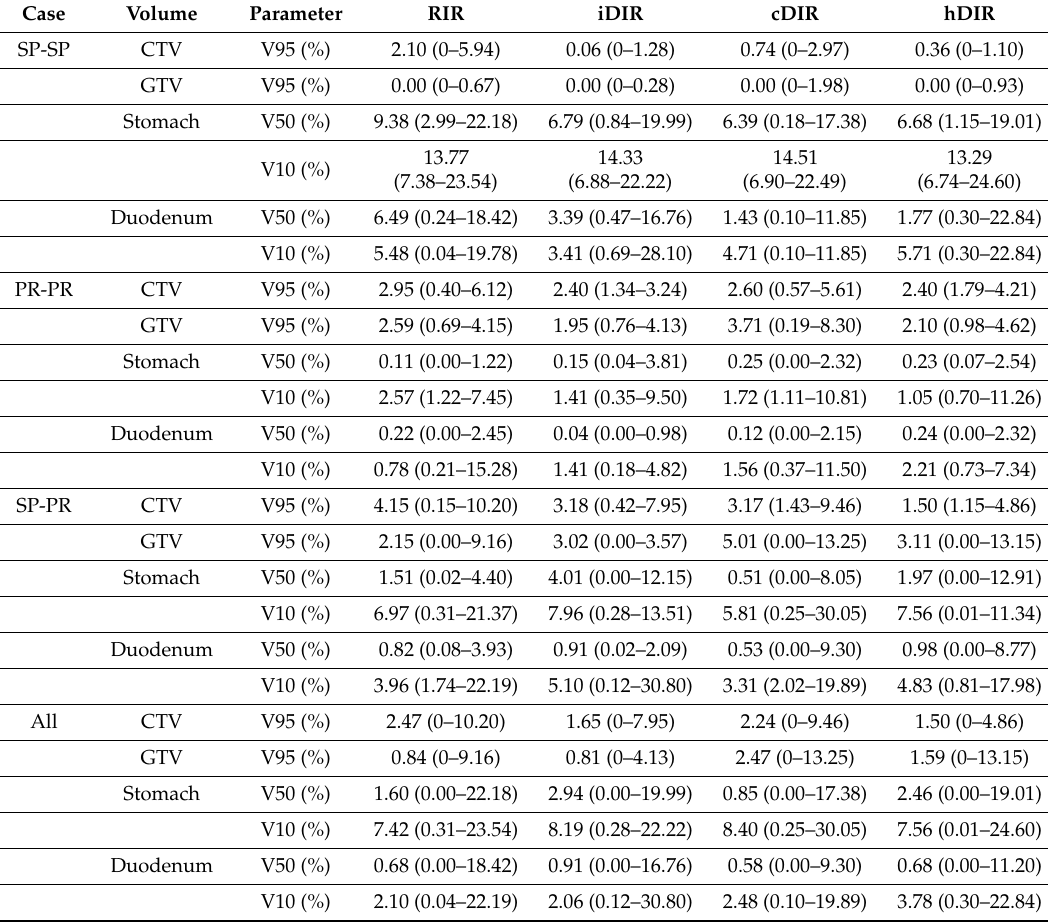
Table 1. Absolute di ff erences in the dose-volume parameters. All data show the median